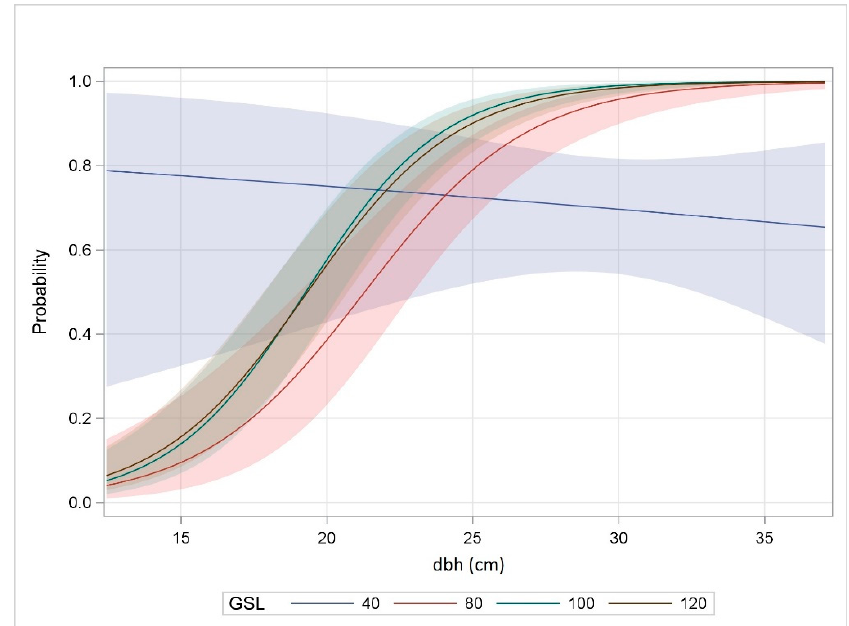
Figure 3. Probability of Dendroctonus ponderosae attacking individual Pinus contorta trees as influenced by growing stock level (GSL) and diameter at breast height (dbh), n = 1415, Fraser Experimental Forest, CO, 2008. Table 3. Significance of pairwise comparisons between growing stock levels (GSL) in the probability of Dendroctonus ponderosae attack to Pinus contorta trees at five diameter at breast height sizes, asterisks denote significant differences at p < 0.05, Tukey’s studentized range test, Fraser Experimental Forest, CO, 2008.